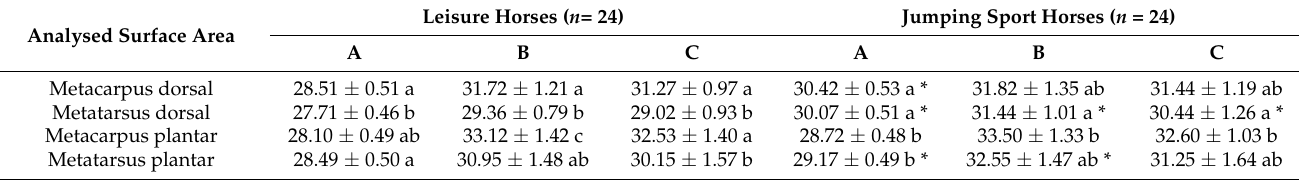
Table 4. Resting temperature ( ◦ C) of the limb surface area under analysis of all warm-up regimes (mean ± SD). Analysed Surface